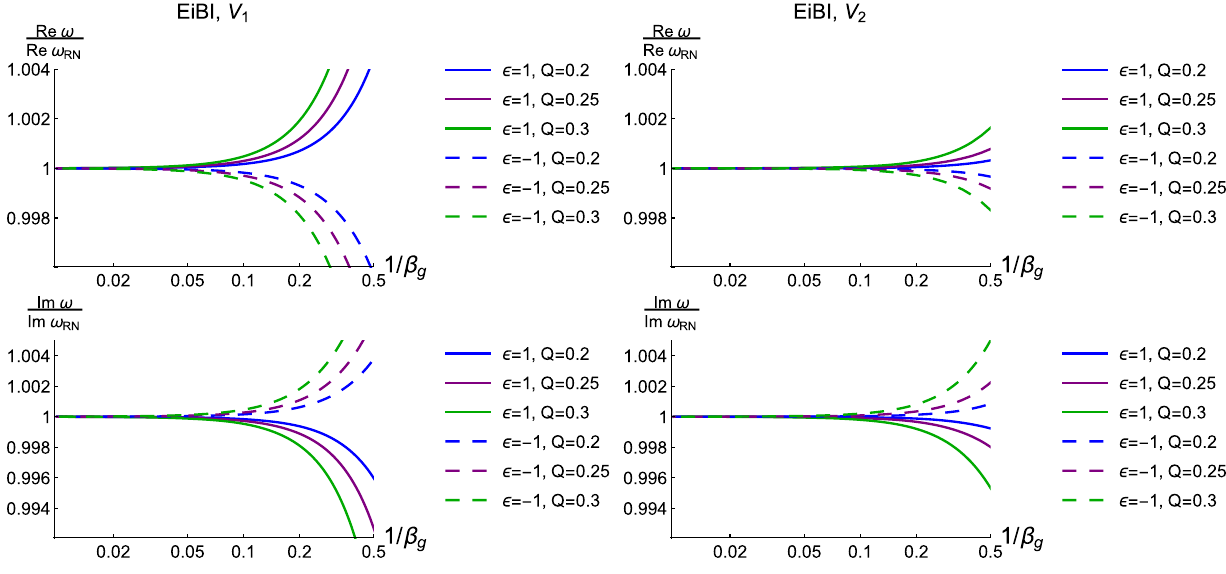
Fig. 2 The real part (upper) and imaginary part (lower) of the fundamental QNM frequencies of the EiBI charged black holes are presented with respect to 1 /β g . The results are based on the potential V 1 (left) and V 2 (right), and the multipole number is fixed to l =